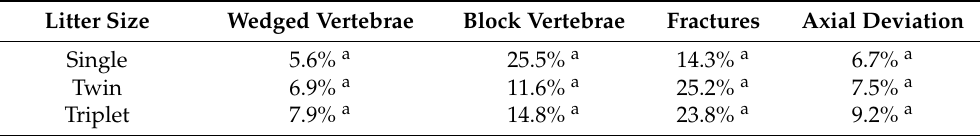
Table 7. LSMeans for the probability of occurrence of wedged vertebrae, block vertebrae, fractures, and axial deviations in the tail region of lambs by litter size. Significant differences ( p < 0.05) are marked with different superscript